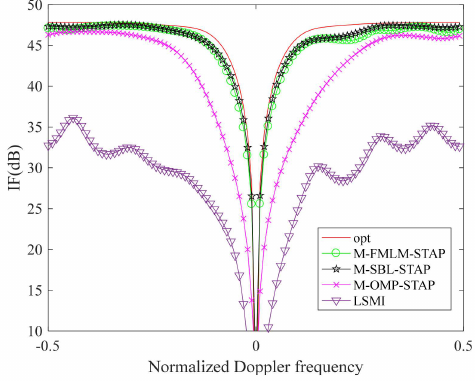
Figure 5. IF curves in the non-ideal case.